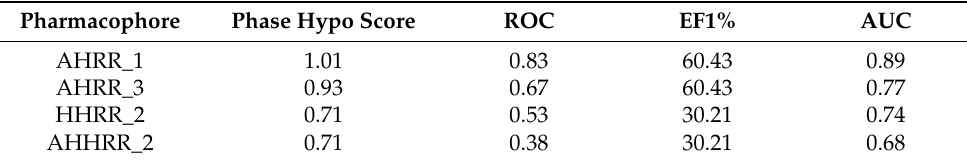
Table 2. Validation of the multiple ligand-based pharmacophore models.